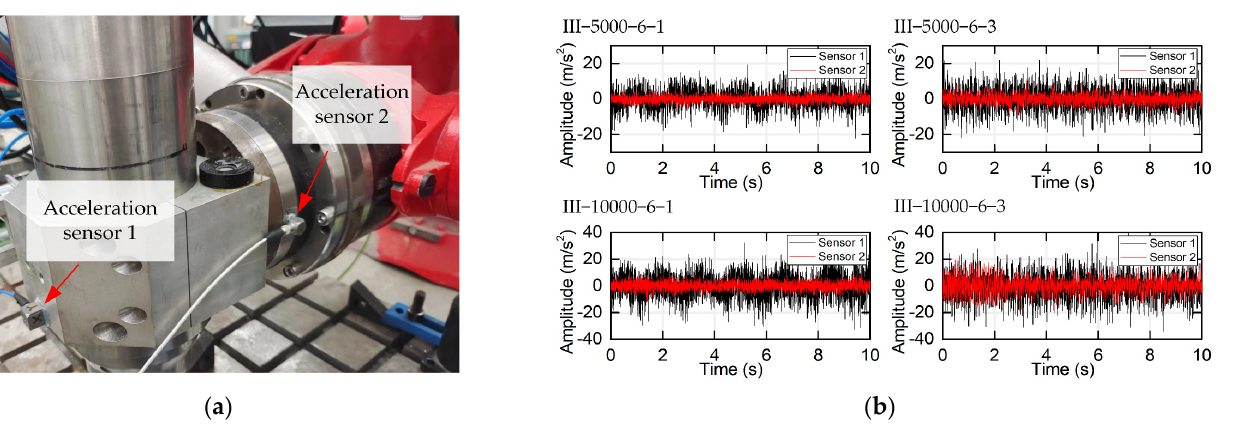
Figure 11. ( a ) Position of two acceleration sensors; ( b ) Comparison of time-domain signals.